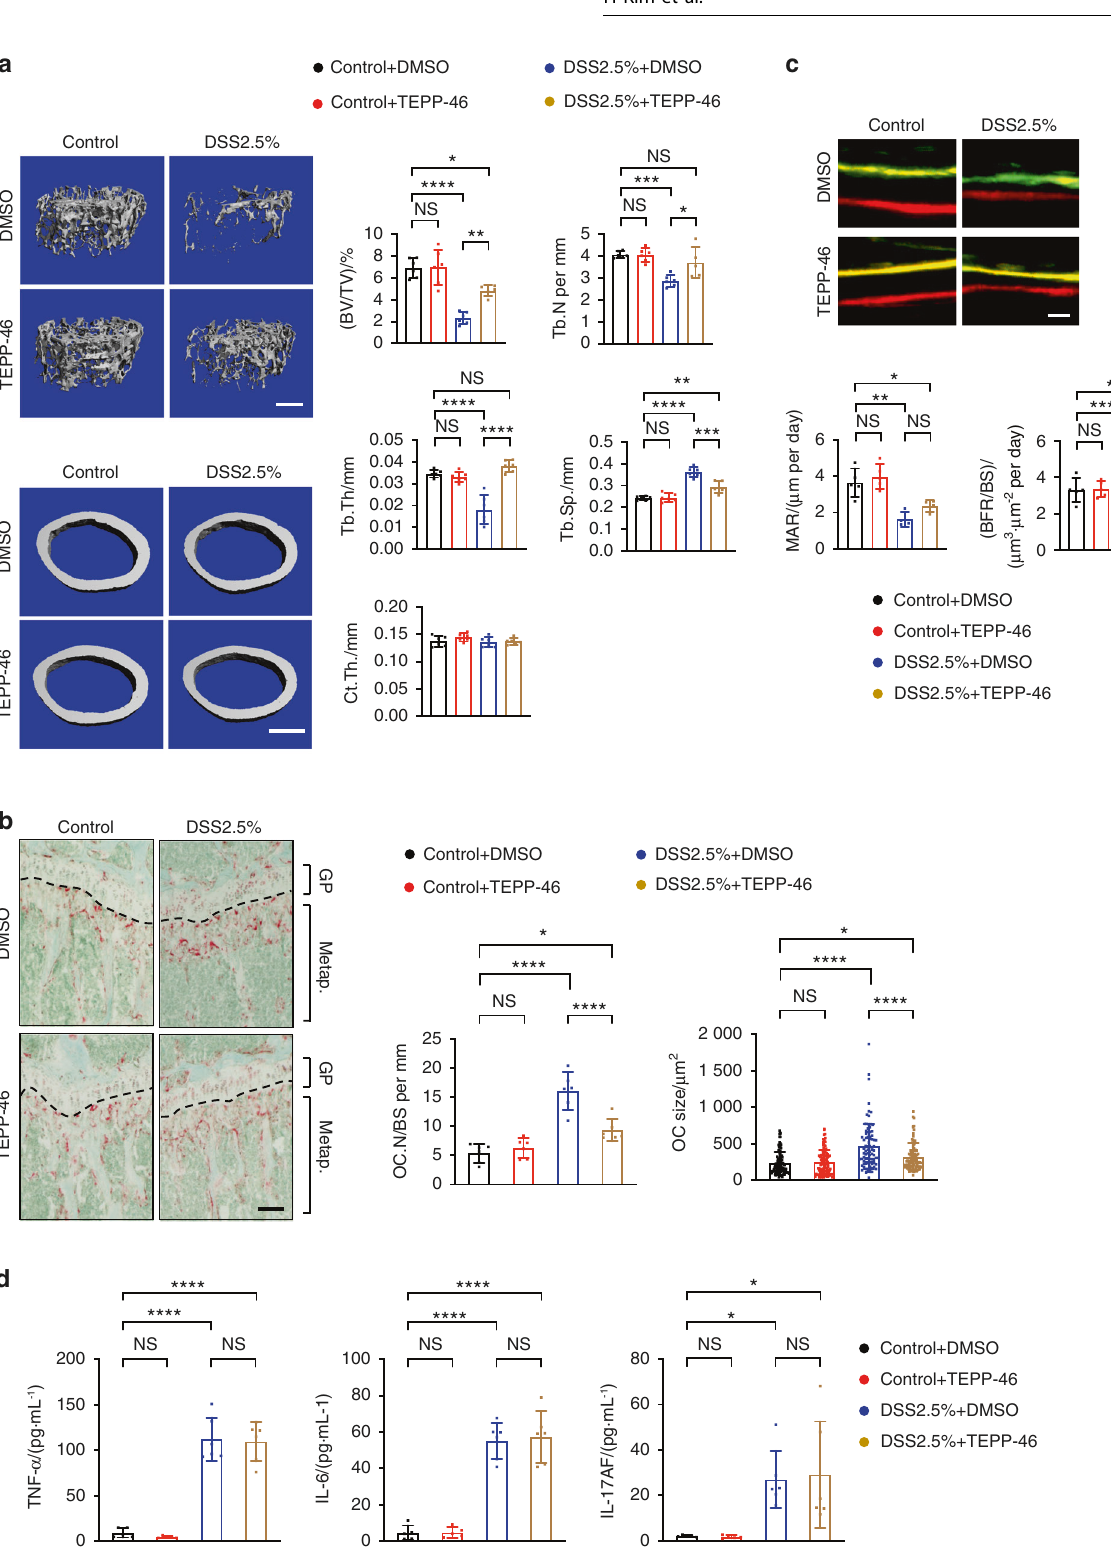
Fig. 6 The activation of PKM2 mitigates colitis-induced osteoclastic bone loss. a Representative μ CT images of the femurs of mice treated with DSS or the control with or without TEPP46. Bone volume per tissue volume (BV/TV), trabecular thickness (Tb.Th), trabecular number (Tb.N), trabecular spacing (Tb.Sp), bone mineral density (BMD), and cortical thickness (Ct.Th) are shown ( n = 4 – 6 mice per group). Scale bars represent 0.5 mm. b Representative TRAP staining images of tibias in ( a ). TRAP + osteoclast size (OC size) and number (OC.N/BS) are shown. The scale bar represents 200 μ m. GP Growth plate, Metap. Metaphysis. c Representative dynamic histomorphometry of tibias in Panel ( a ). The mineral apposition rate (MAR) and bone formation rate (BFR) are shown. The scale bar represents 20 μ m. d Serum levels of TNF- α , IL-6, and IL- 17AF from the mice in ( a ) were measured by ELISA. Each dot represents the result of a single mouse. Each dot in OC size represents the result of a single osteoclast. The data are presented as the means ±